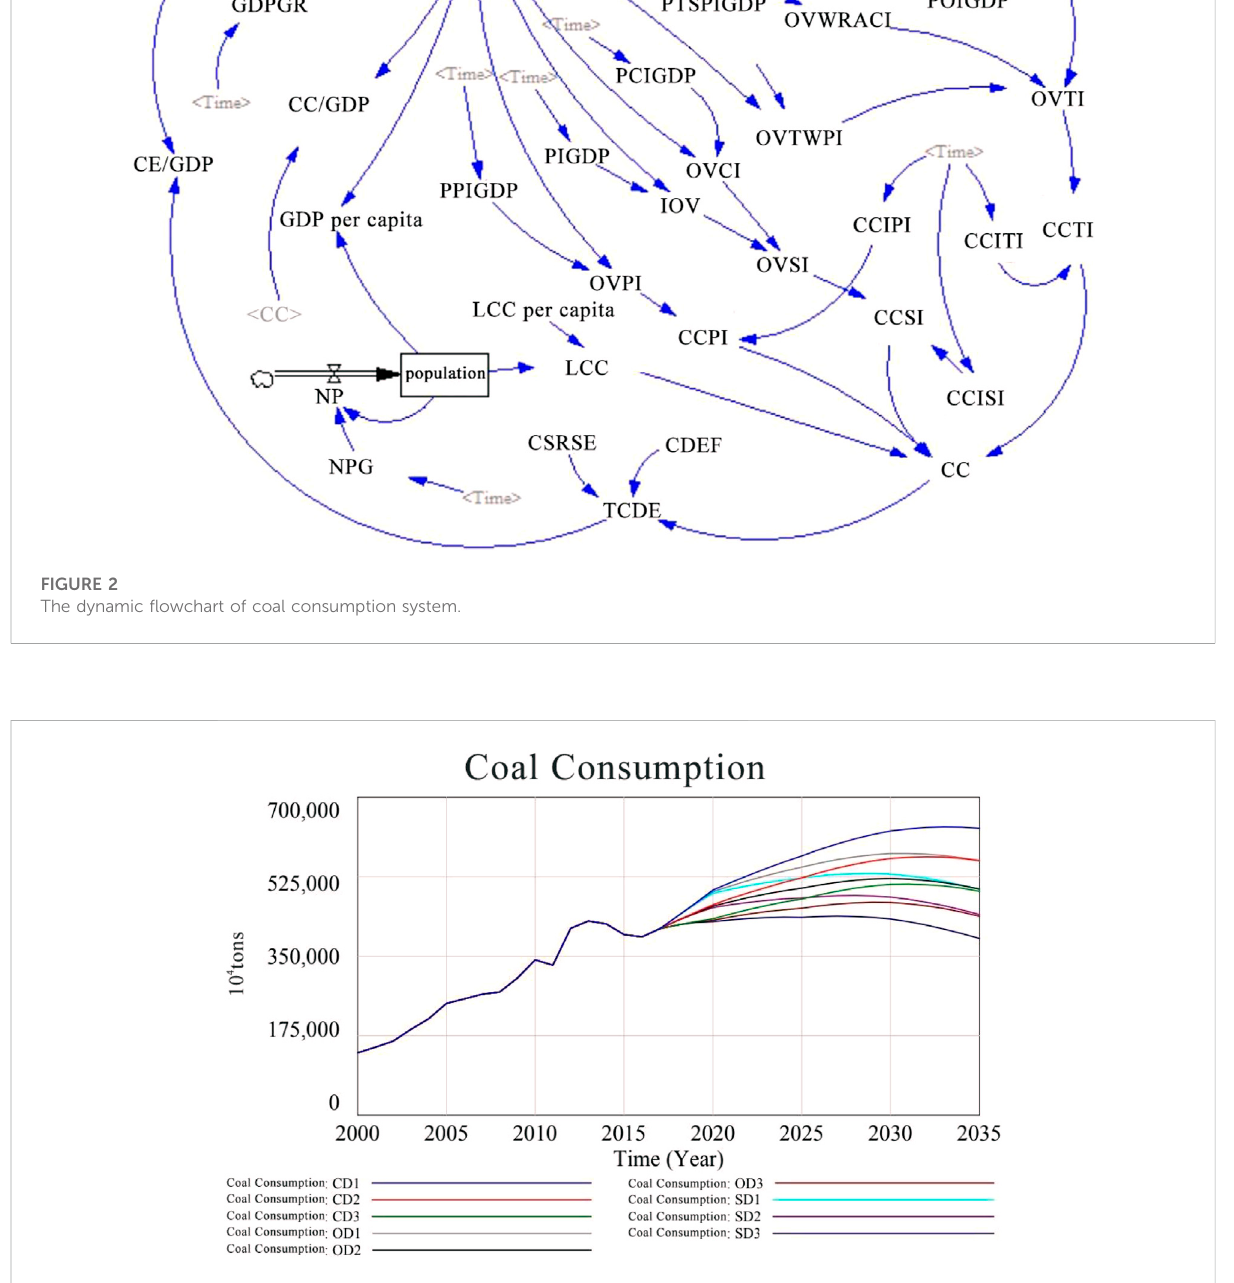
FIGURE 3 Scenario simulation of China ’ s coal